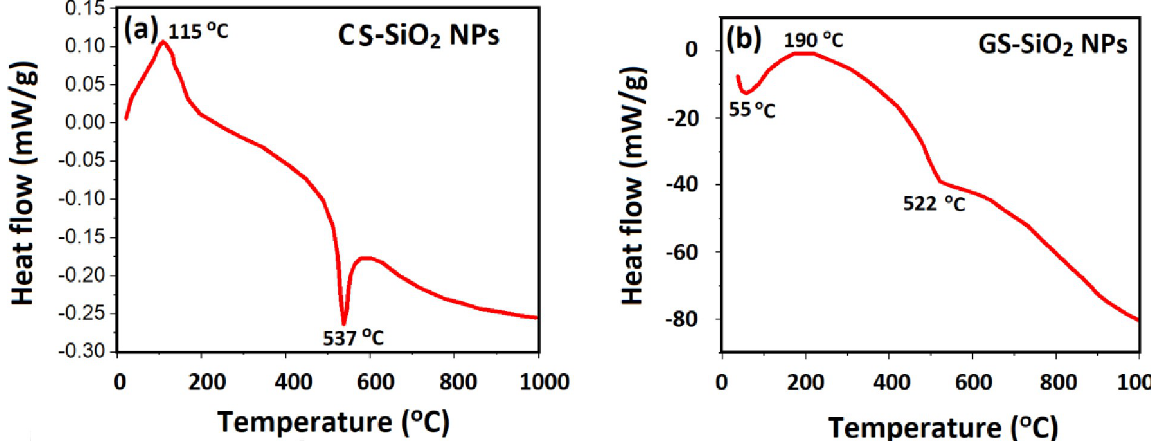
Fig 10. DSC analysis for (a) CS-SiO 2 NPs and (b) GS-SiO 2 NPs.